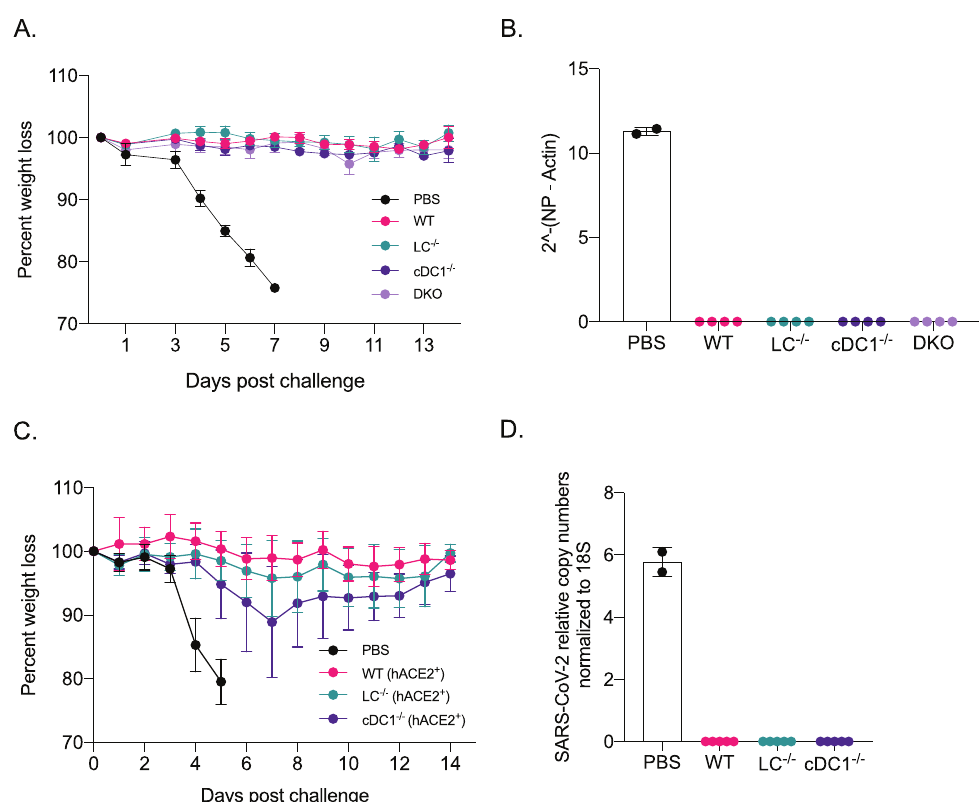
Fig 2. The mRNA-LNP platform supports the development of protective immune responses towards flu and SARS-CoV-2 even in the absence of certain DC subsets. A . The indicated animals were immunized with 10 μ g of mRNA-LNP coding for PR8 HA or injected with PBS. Fourteen days later the animals were challenged with 5,000 TCDI PR8 influenza virus and the weight drop monitored as presented. Data from two independent experiments pooled, 5–8 mice/group. B . Lung samples harvested 7 days post PR8 challenge were assessed using RT-qPCR for viral RNA. C . As in A , but the indicated mice were immunized using 5 μ g of mRNA-LNP coding for SARS-CoV-2 RBD and then 14 days later challenged with 10 5 PFU SARS-CoV-2. Data from two independent experiments were pooled, 7–10 mice/group. D . as in B , except the lung samples were tested for the presence of SARS-CoV-2 using qPCR. Each dot represents a separate